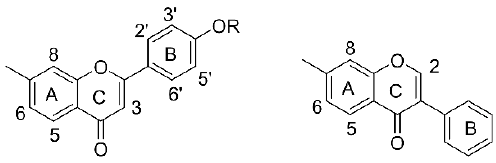
Figure 9. Structures of Flavonoids.